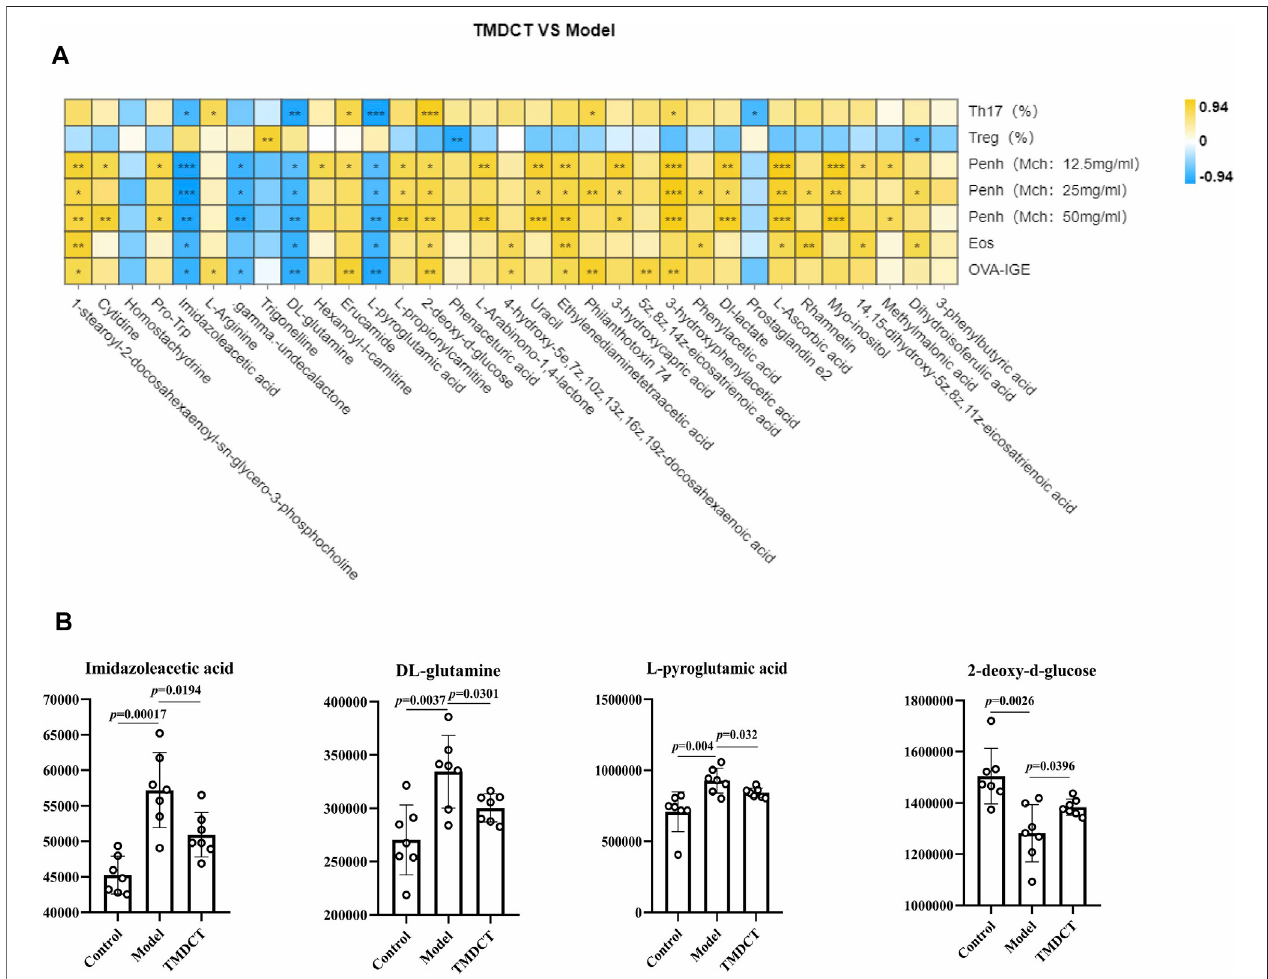
FIGURE 4 | Biomarker selection of plasma metabolites associated with Treg/Th17 balance. (A) Correlation analysis of differential plasma metabolites with speci fi c OVA-IgE,Penhvalue(Mch:12.5,25,50 mg/ml),EosinophilnumberinBALF,TregandTh17cellspercentage.* p < 0.05,** p < 0.01,*** p < 0.001. (B) Biomarkerinplasma metabolites associated with Treg/Th17 balance. n = 7 animals per